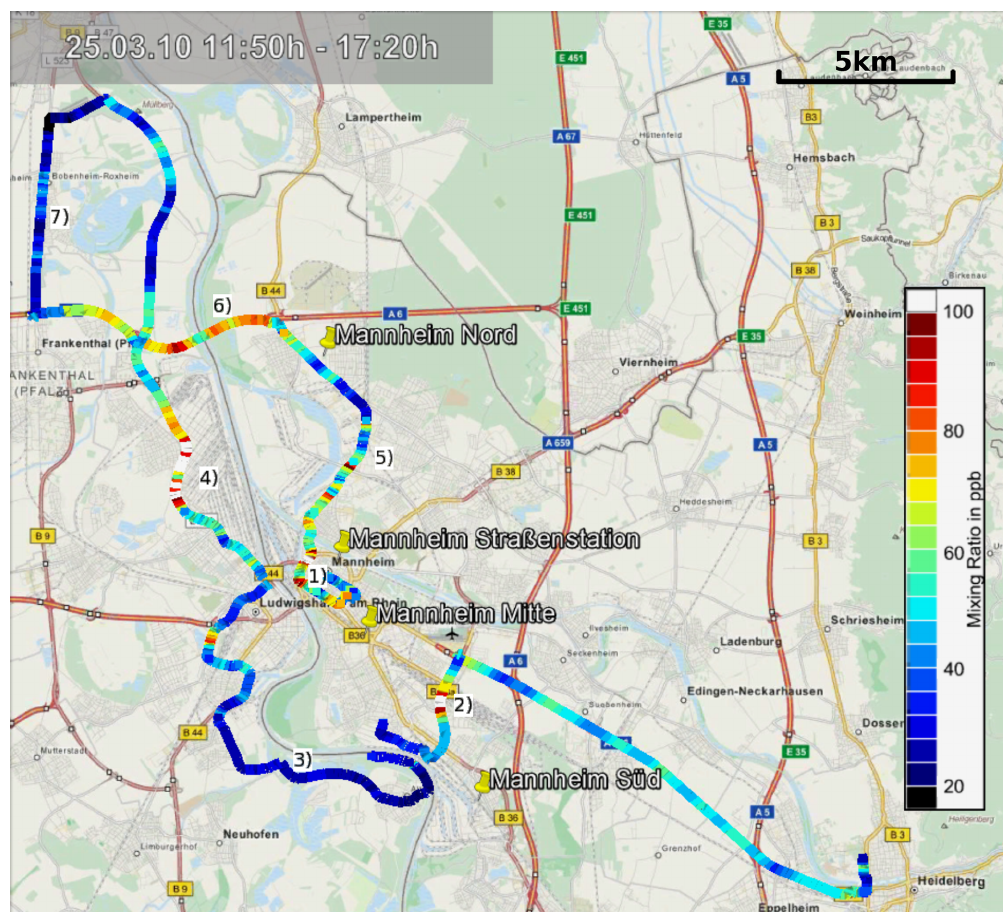
Figure 14. Overview of the car-based measurements in the greater Mannheim–Ludwigshafen urban area. The colour of the route segments corresponds to the local NO 2 mixing ratio. The areas marked on the map are (1) Mannheim city centre, (2) Mannheim railroad shunting yard, (3) Mannheim suburbs Altrip and Rheingönheim, (4) BASF industrial plant, (5) main road B44, (6) autobahn A6, (7) suburb Bobenheim- Roxheim. The yellow pins show the locations of the LUBW, air quality monitoring stations in the measuring area. The map overlay was created with Google Earth. Map information provided by MapQuest, OpenStreetMap,